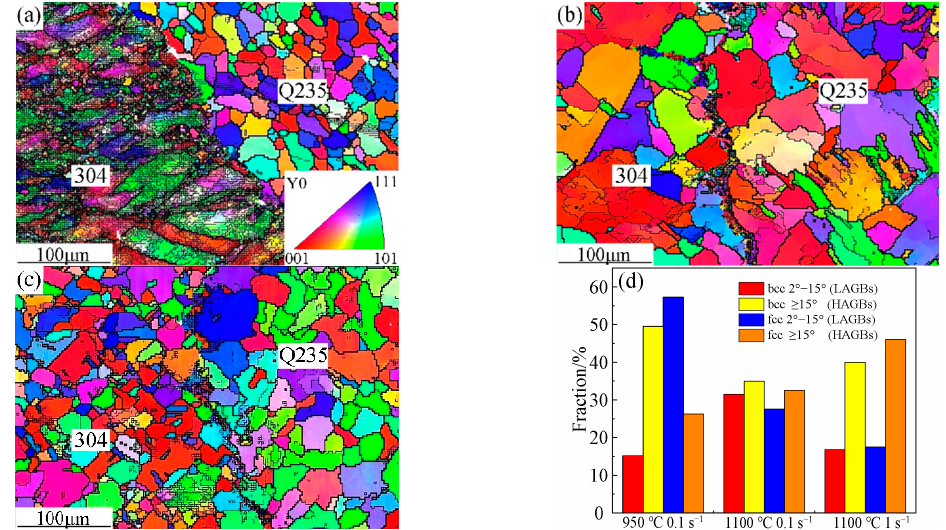
Figure 4. IPF + grain boundary of each phase at ( a ) 950 °C, 0.1 s − 1 , ( b ) 1100 °C, 0.1 s − 1 and ( c ) 1100 °C, 1 s − 1 and their ( d ) volume